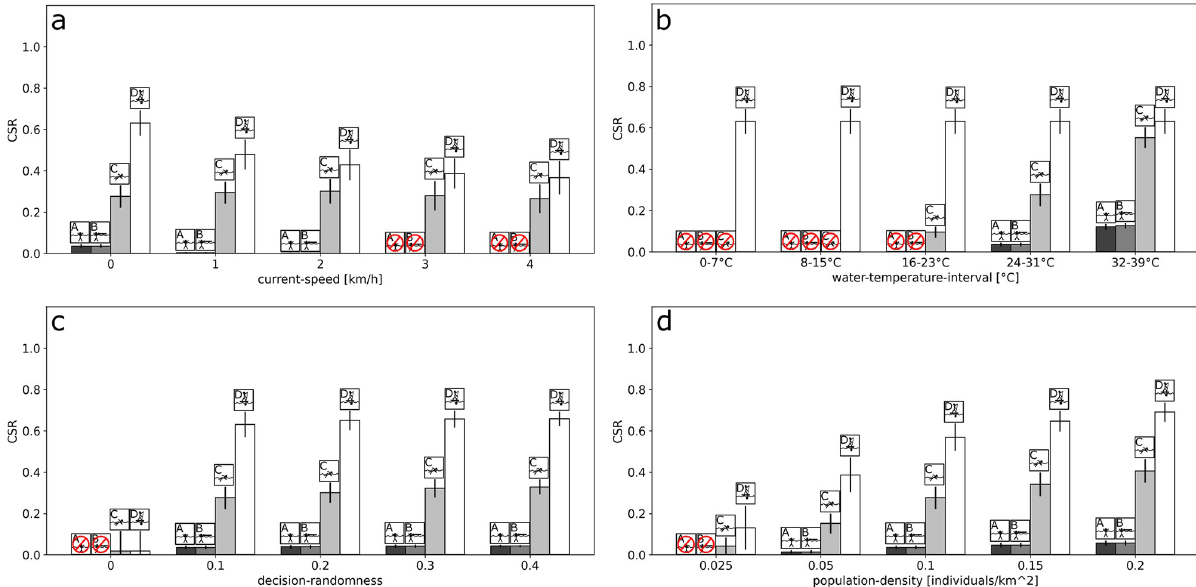
Fig 7. One-factor sensitivity with respect to average CSRs. The one-factor sensitivity experiments show how the systematic variation of the levels of a single factor affect the average CSR response. Results are shown for current-speed (a), water-temperature-interval (b), decision-randomness (c) and population-density (d). The behavioral scenarios are represented by the icons. Crossed out red circles indicate no successful crossing (CSR = 0).